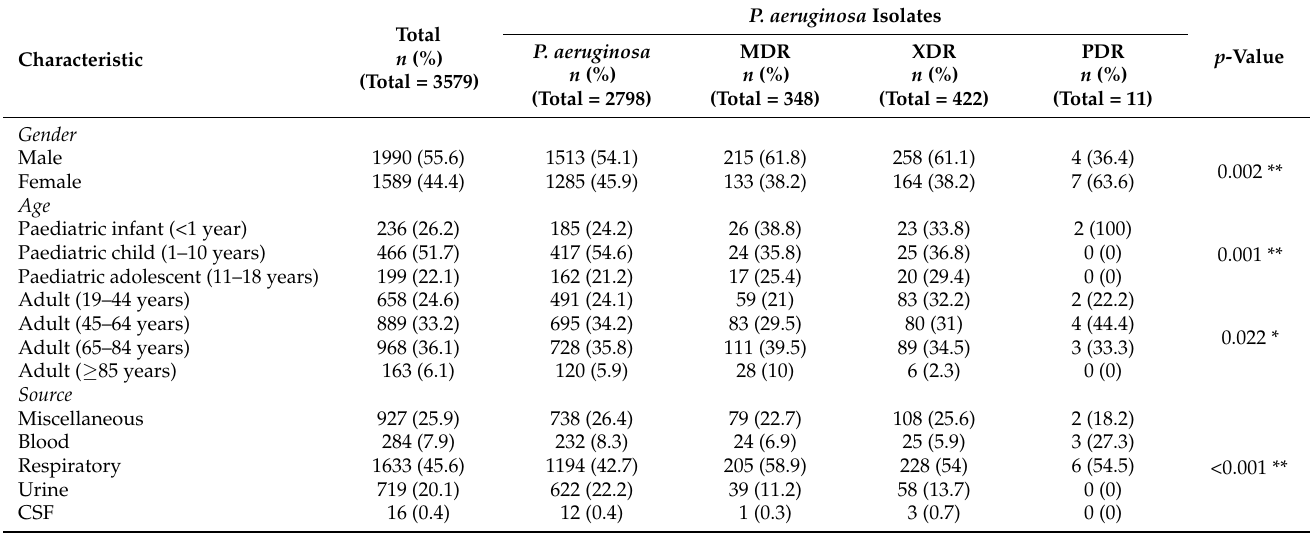
Table 1. Distribution of multi-resistant P. aeruginosa isolates according to gender, age, and sample source and